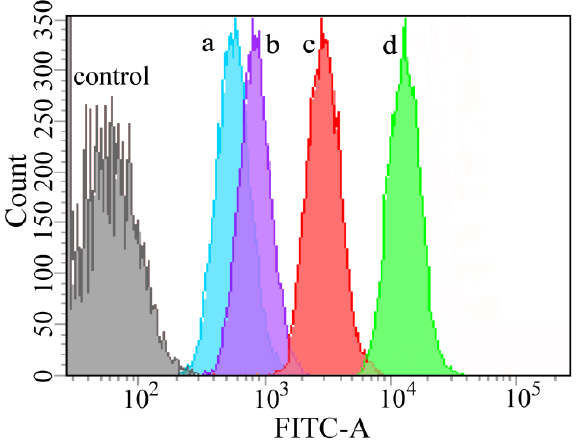
Figure 7. Flow cytometry analysis of HeLa cells treated with free Cur for 1 h ( a ), PCPt NPs for 1 h ( b ), free Cur for 4 h ( c ), and PCPt NPs for 4 h ( d ).